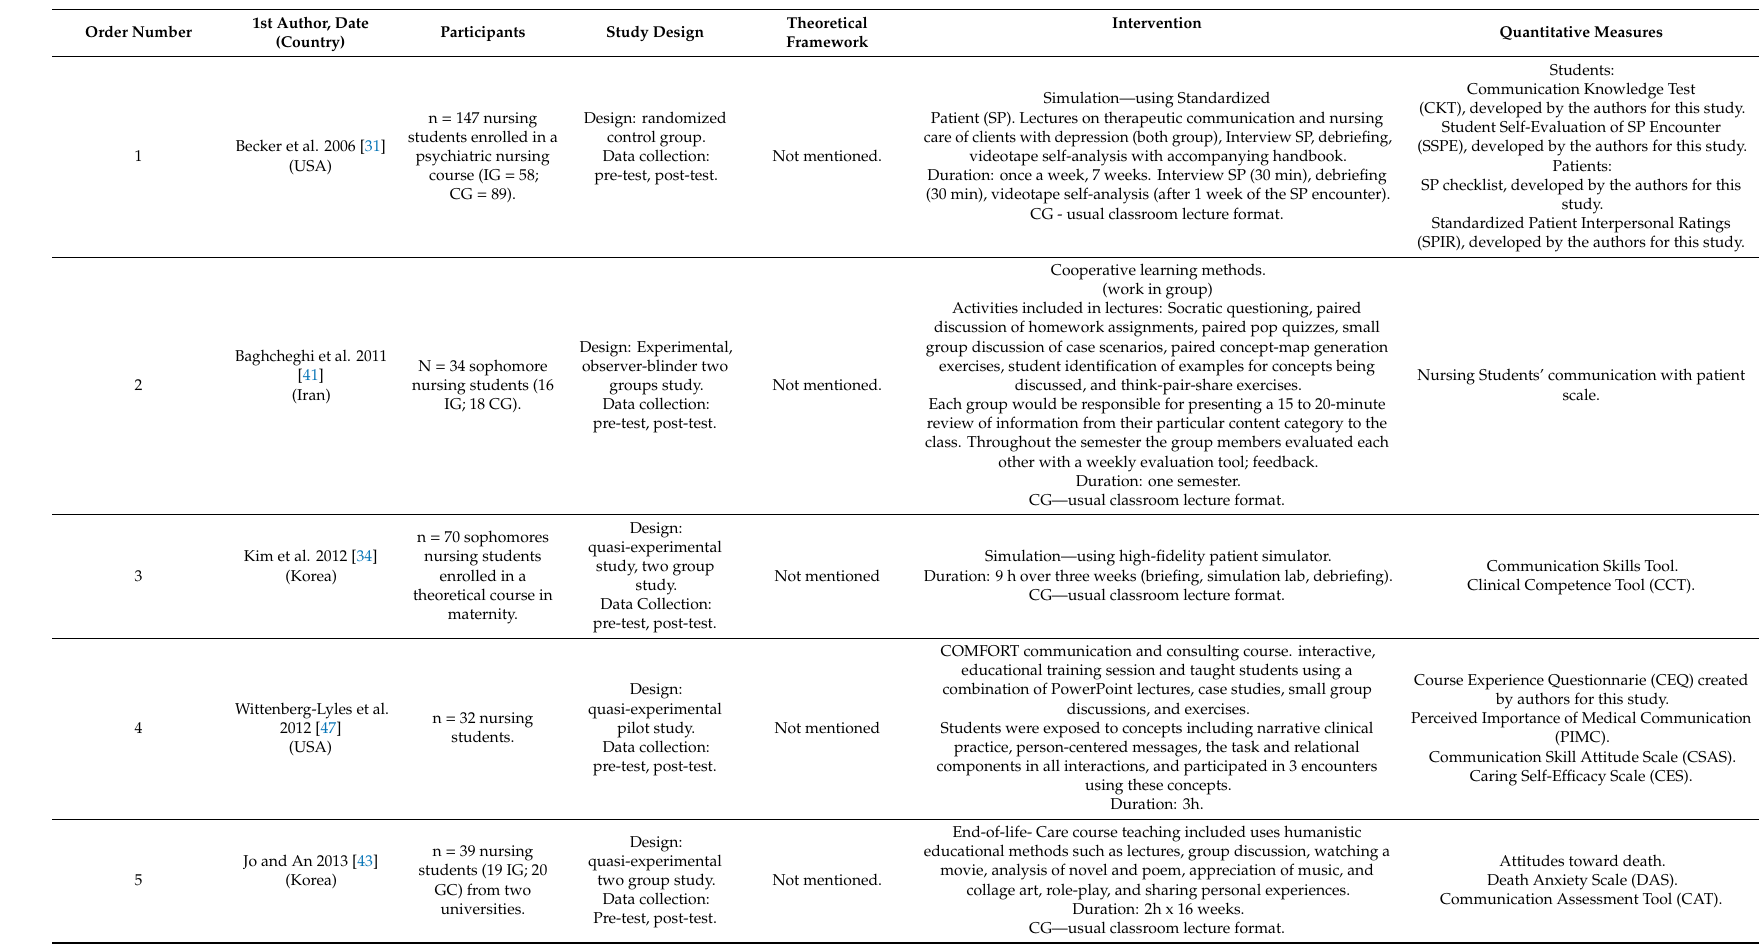
Table 2. Intervention